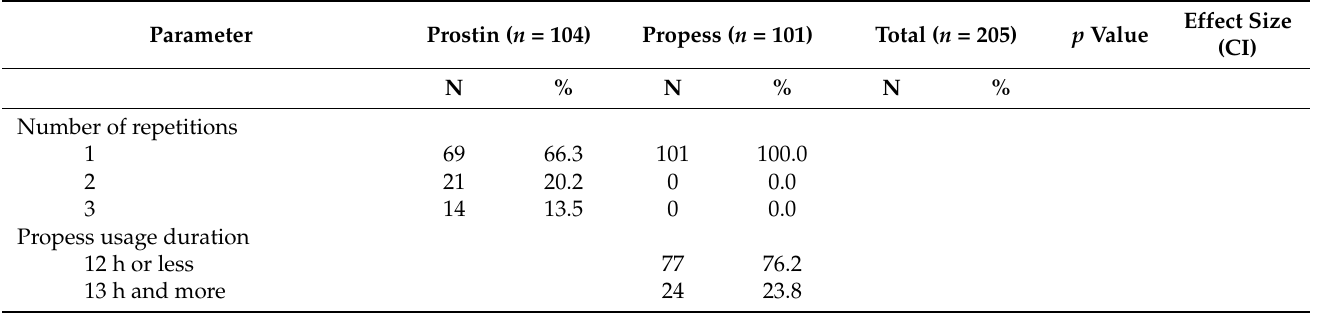
Table 2. Induction data of the study population according to the study groups. N—number of cases, %—percentage of the group, CI—confidence